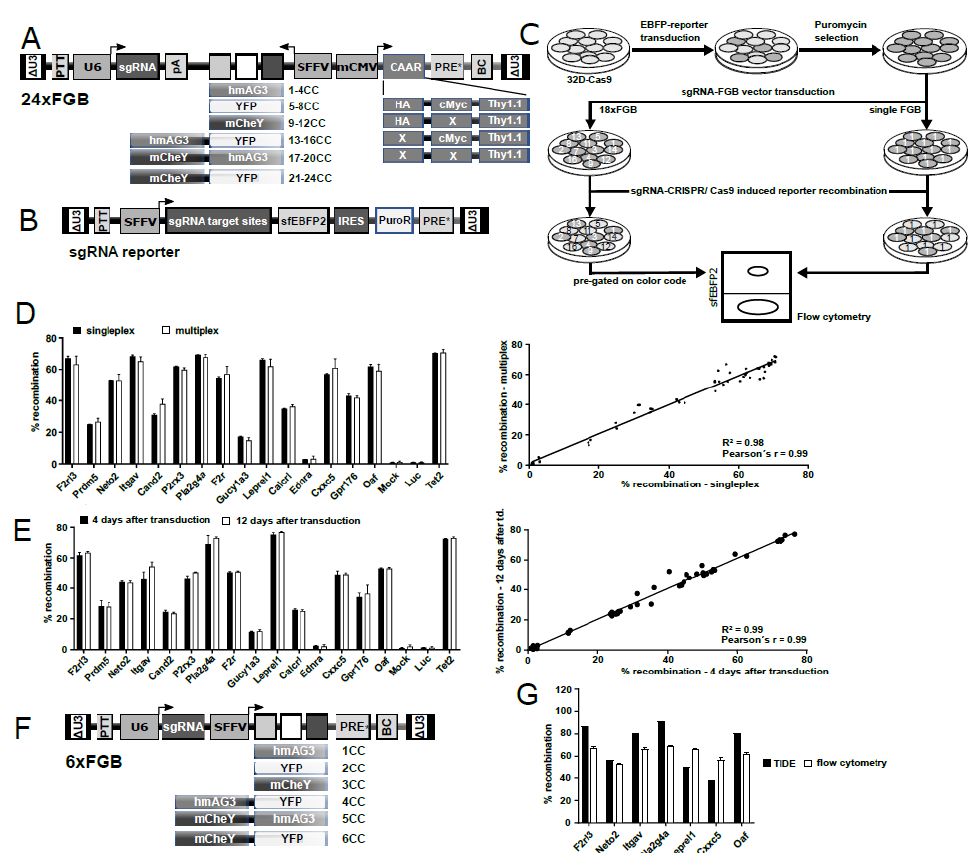
Figure 2. Multiplex sgRNA screen. ( A ) Schematic design of the lentiviral 24xFGB multiplexing vector platform for functional interrogation of sgRNAs. The vector carries a bidirectional design, where a spleen focus-forming virus (SFFV) promoter expresses a fluorescent marker cassette in antisense orientation. The minimal CMV (mCMV) promoter drives the expression of a chimeric antigen array (CAAR) surface marker cassette. The CAAR is made up of a Thy1.1 membrane anchor, which additionally carries permutations of binding and non-binding (X) HA and cMyc epitope tags on its extracellular domain for antibody-mediated detection. The sgRNAs are embedded between the U6 promoter and the inverse polyadenylation signal (pA). ( B ) Schematic design of a fluorescent reporter for the assessment of sgRNA activity. A fusion construct consisting of the translated sgRNA target sites and a superfolder enhanced blue fluorescent protein (sfEBFP2) was cloned between the SFFV promoter and an internal ribosome entry site (IRES)-dependent puromycin resistance gene. ( C ) Schematic experimental design for the assessment of sgRNA activity. 32D cells stably expressing Cas9 were transduced with the sgRNA-sfEBFP2 lentiviral reporter construct ( B ), selected with puromycin and, afterwards, transduced with 18 sgRNA-expressing FGB vectors in independent wells. Transduced cells were assessed for reporter cleavage by flow cytometric analysis of individual wells (singleplex) or of mixes of 18xFGB (multiplex) samples, respectively. ( D ) Comparative recombination efficiency of the sgRNA reporter in singleplex as well as 18xFGB multiplex samples (mean ± SD, n = 3) 7 days post transduction. Linear regression analysis revealed a high correlation between singleplex and multiplex measurements (R2 = 0.98, Pearson’s r = 0.99). ( E ) Comparison of recombination rates assessed 4 and 12 days post transduction in singleplex experiments (mean ± SD, n = 3). Linear regression analysis showed a stable frequency of recombination between both time points (R2 = 0.99, Pearson’s r = 0.99). ( F ) Schematic vector design of the 6xFGB platform for the assessment of sgRNA activity. The U6 promoter drives the sgRNA expression. Likewise, the SFFV promoter drives the expression of a fluorescent marker cassette, and each of the color codes (CC) carries a unique DNA barcode (BC). ( G ) Comparison of gene editing efficiencies in 32D cells measured by flow cytometry versus H9M-Cas9 cells based on TIDE analysis (mean ± SD, TIDE n = 1, flow cytometry n = 3). ∆ U3, self-inactivating long terminal repeat; PPT, polypurine tract; hmAG3, human codon-optimized Azami Green fluorescent protein variant; YFP, yellow fluorescent protein; mChEY, monomeric mCherry fluorescent protein variant; PRE*, posttranscriptional regulatory element; BC, DNA